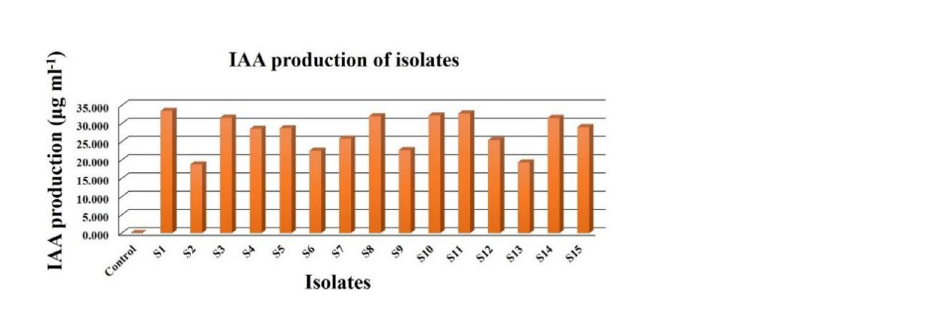
Figure 1. IAA production profile of isolates.